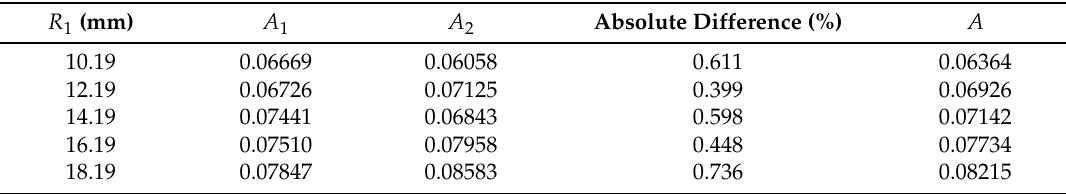
Table 6. Absolute difference of | A 1 ´ A 2 | and the values of A for different R 1 .